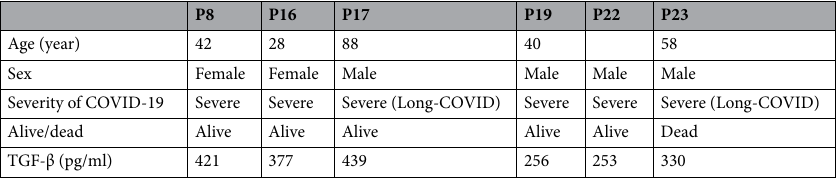
Table 3. Demographic characteristics of COVID-19 patients with lung